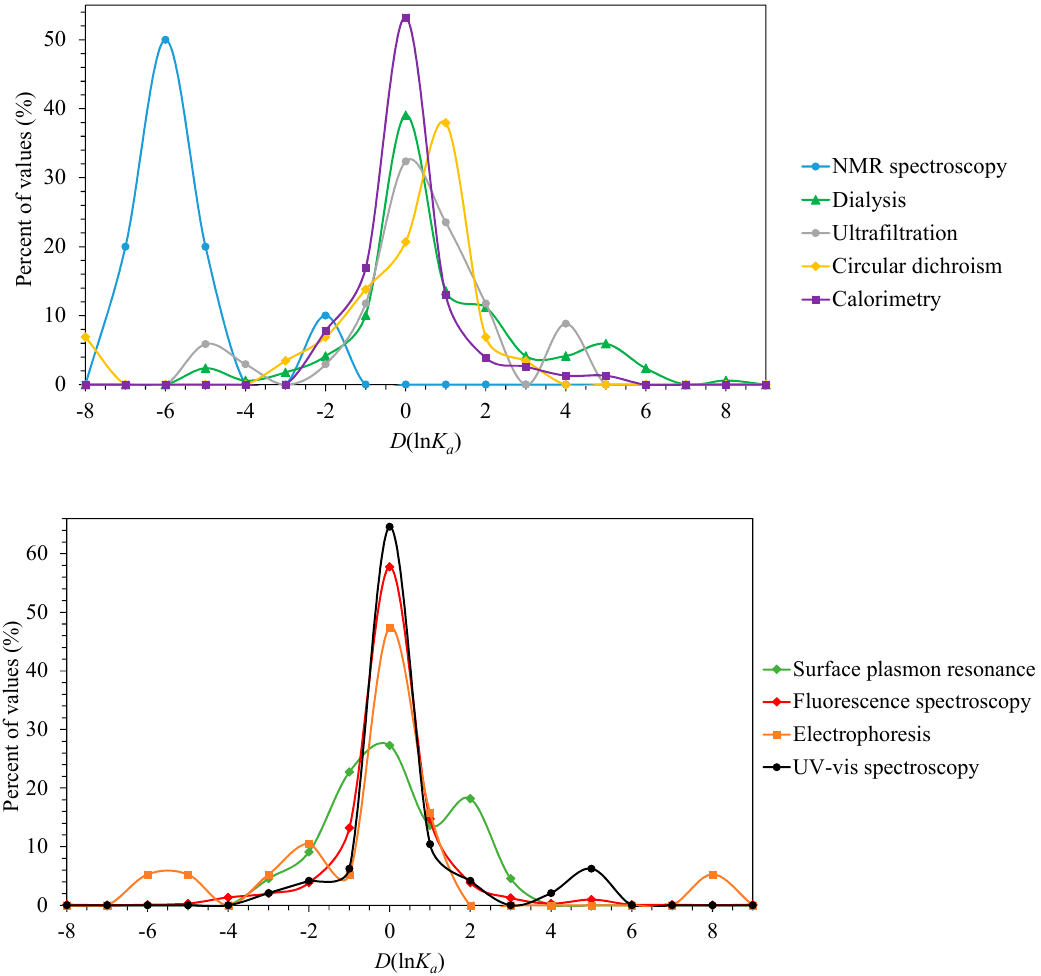
Figure 8. Distributions of the number of values of the binding constants binned by their deviation D ( ln K a ) from the median binding constant for the given ligand and albumin type. A separate distribution is plotted for each common experimental method of the binding constant measurement .